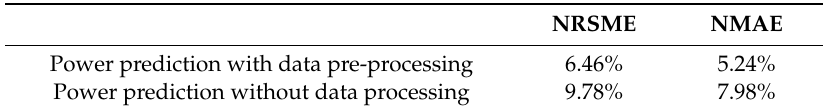
Table 2. The NRSME and the NMAE of wind power prediction with data pre-processing and wind power prediction without data